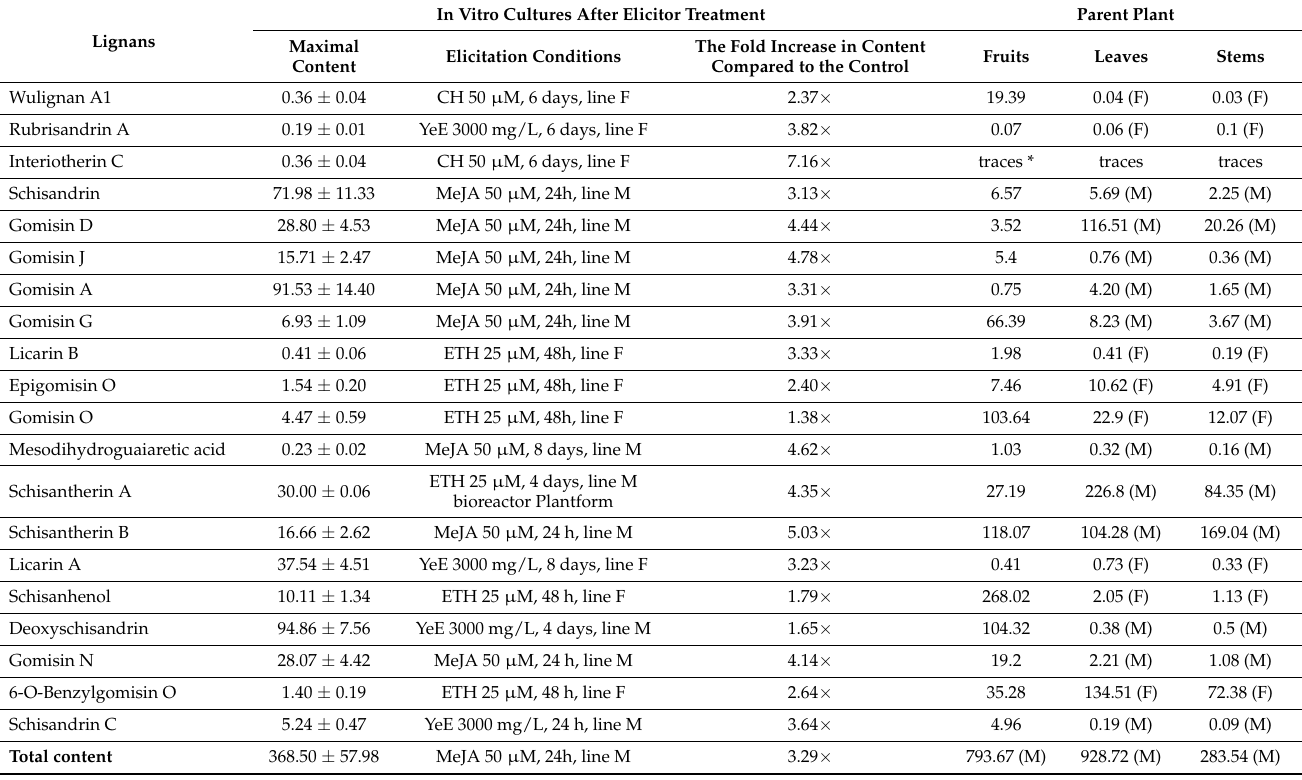
Table 9. Comparison of maximum lignan contents (mg/100 g DW) obtained from elicitation experi- ments on microshoot cultures of lines F and M with their contents in the fruits, leaves and shoots of the parent plant S. rubriflora